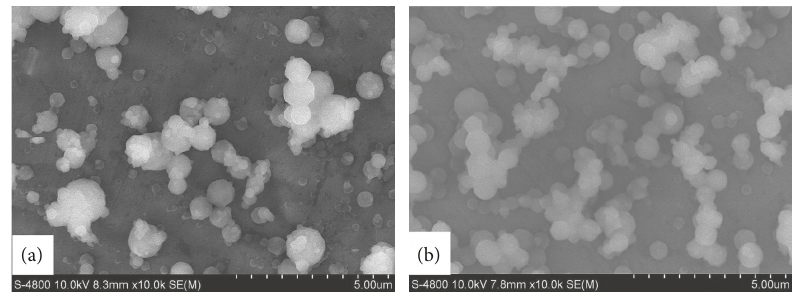
Figure 10: SEM images of the nanoparticles in 2.0 wt.% chitosan concentration at a different voltage (U) and distance (L). (a) M2 chitosan at L � 12cm, U � 18kV; (b) M3 chitosan at L � 10cm, U � 12kV. Effects of working parameters on M3 solution at 1.5 wt.% chitosan in 90 wt.% acetic